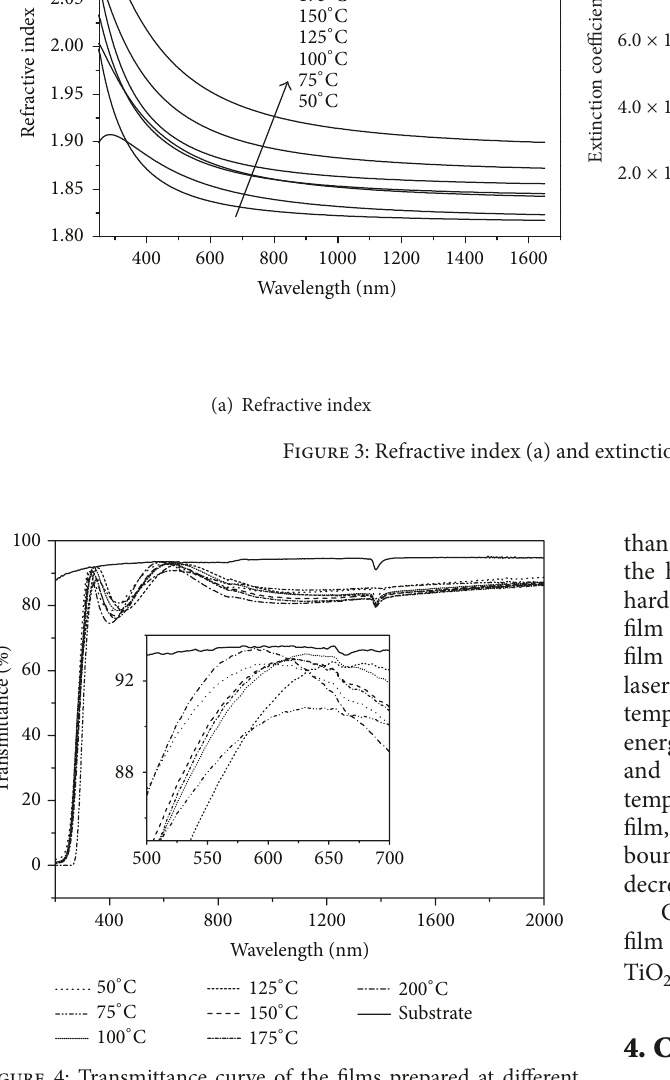
Figure 4: Transmittance curve of the films prepared at different deposition